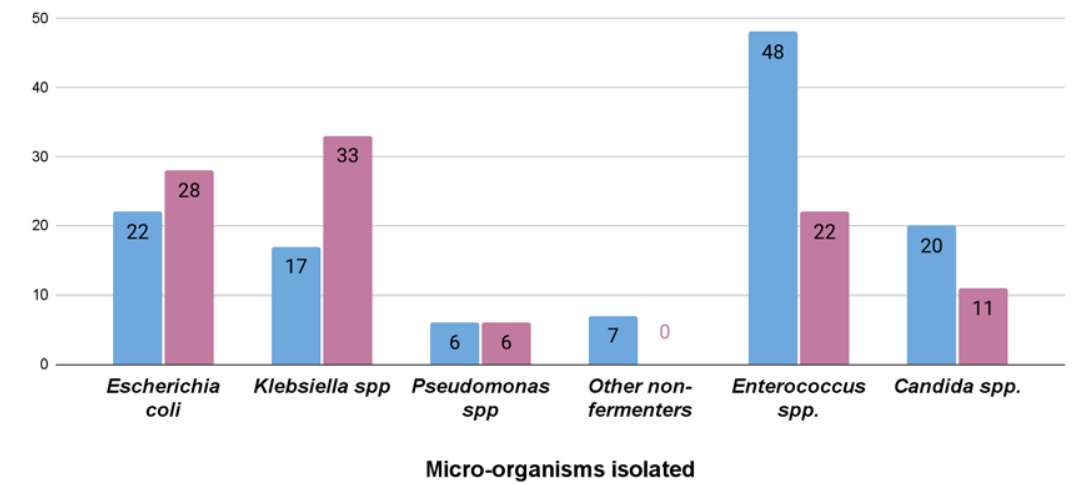
Figure 3. Percentage (%) of different bacterial isolates obtained from the samples from urinary tract infections from adult and pediatric intensive care infections from adult and pediatric intensive care units.